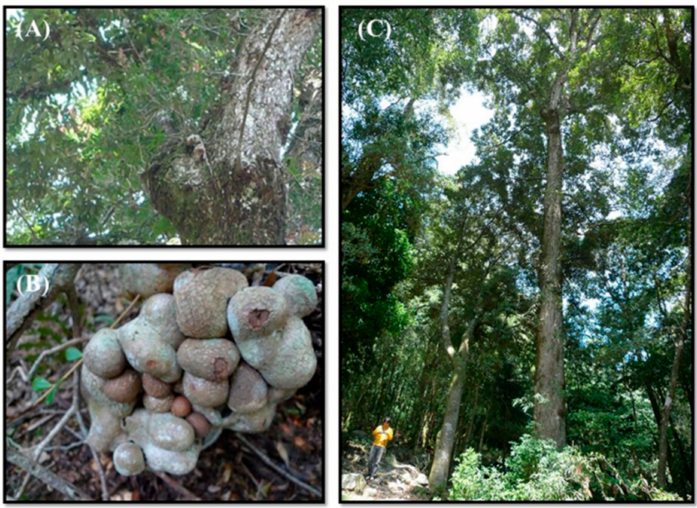
Figure 1. V. emarginatum Hayata is an epiphytic shrub grow on the branch of the tree ( A ) in the broad-leaved forests ( C ) with enlarged root nodules ( B ) storing the water and